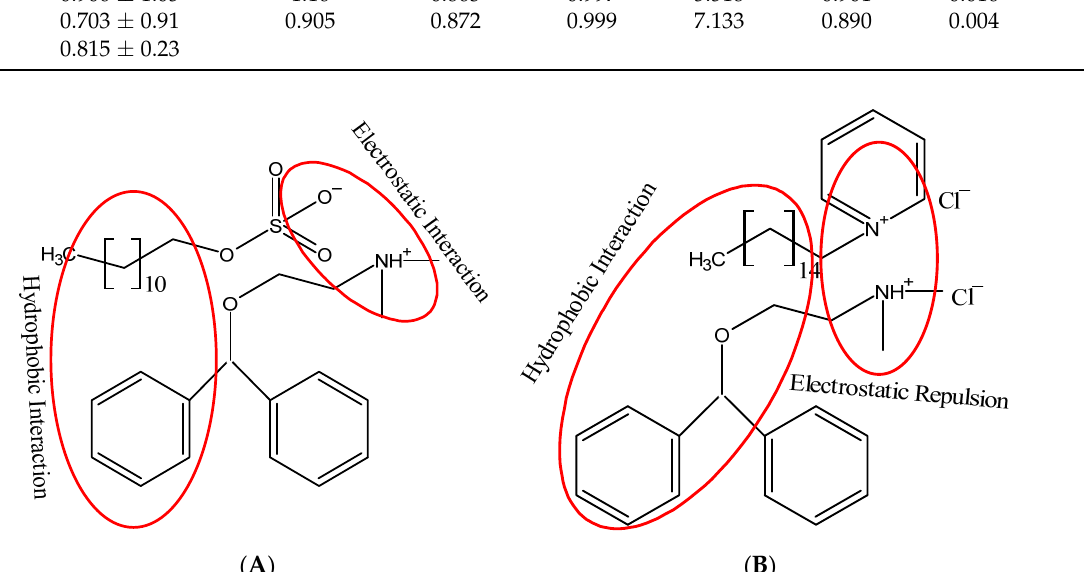
Figure 4. Schematic representation of the interactions (hydrophobic and electrostatic) between ( A ) DPH + SDS, ( B ) DPH + CPC.